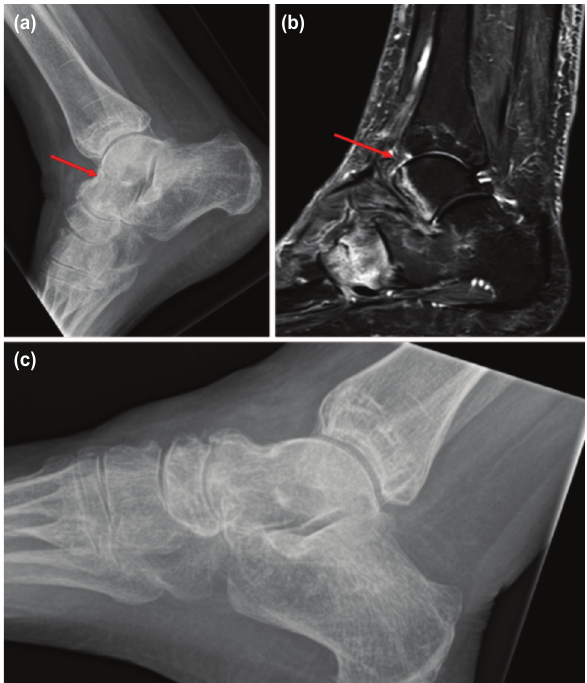
(a) Plain radiograph of the talus showing insufficiency Fig. 3: fracture, (b) T2 weighted MRI scan of the talus showing the fracture. (c) Plain radiograph of the talus showing healed